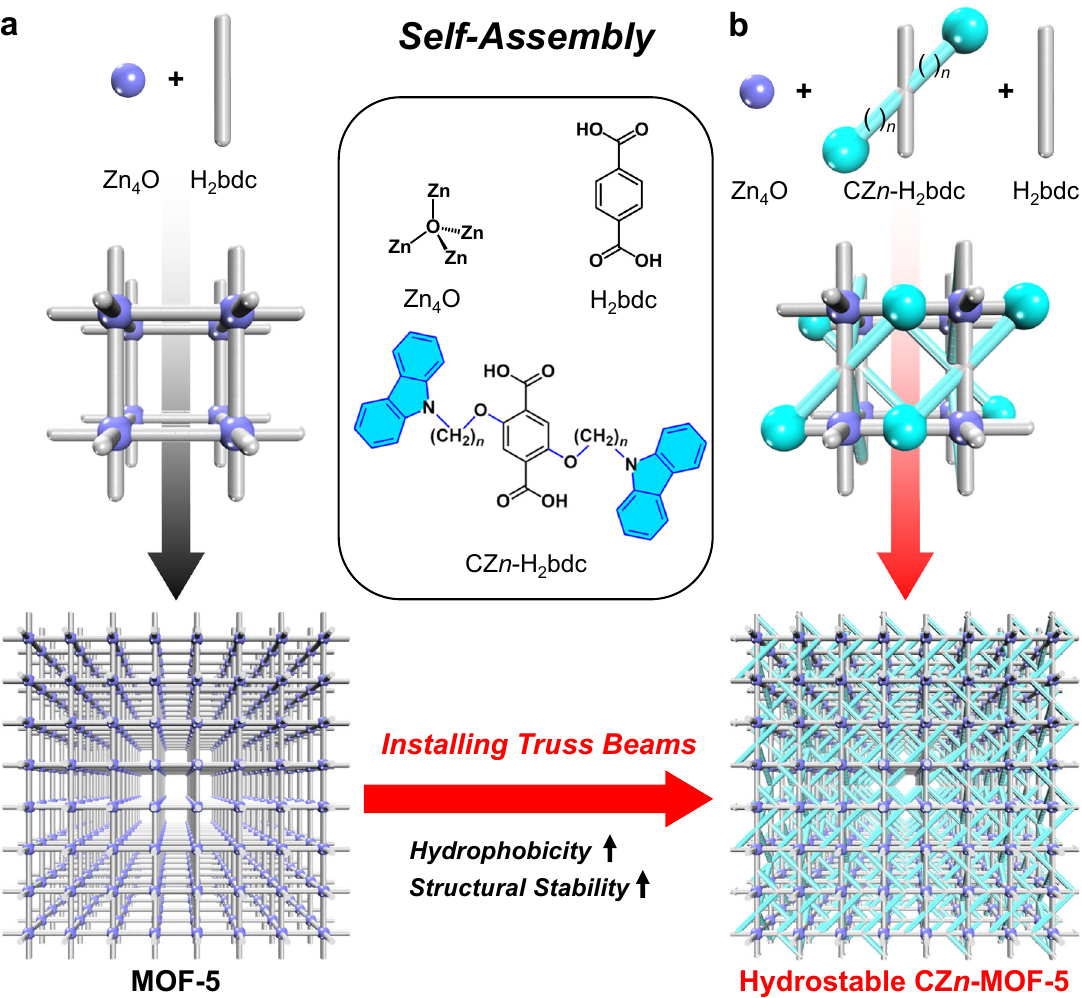
Fig. 1 Schematic illustration of installing a molecular truss beam to enhance hydrolytic stability of metal-organic frameworks. a MOF-5. b CZ n -MOF-5 by shielding the zinc oxide site and rigidifying the frameworks in a combination of 1,4-benzenedicarboxylic acid (H 2 bdc) and 2,5-bis( n -(9H-carbazol-9-yl)-propoxy)-1,4-benzenedicarboxylic acid (CZ n -H 2 bdc) ligands ( n = 3 and